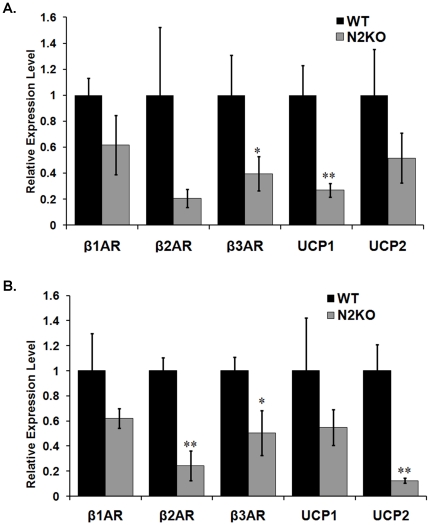
Expression profile in BAT and WAT.Relative quantitative expression levels for b-adrenergic receptors (β1AR, β2AR and β3AR) and uncoupling proteins (UCP1 and UCP2) in RNA isolated from BAT (A.) and WAT (B.). The data is reported as the mean expression level relative to WT expression ± SEM. (*p≤0.05, **p≤0.01).